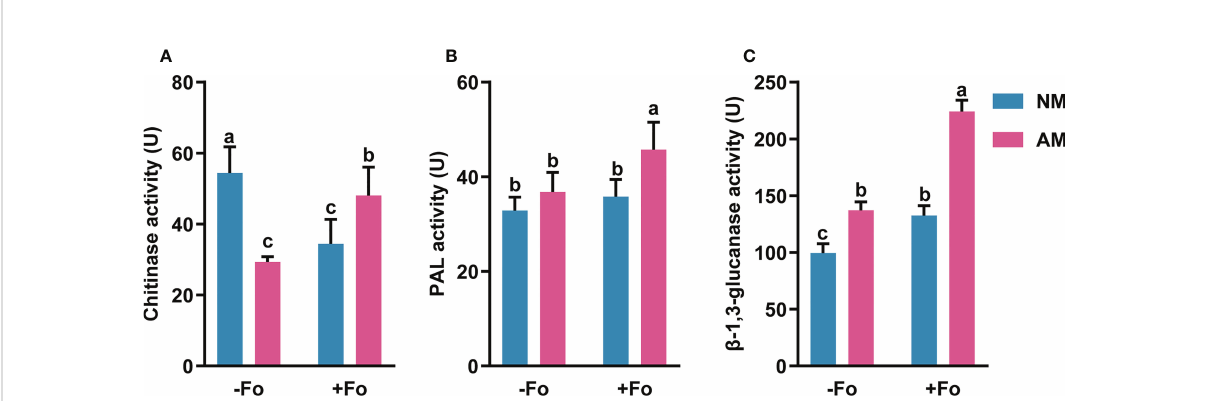
FIGURE 4 The activity of chitinase (A) , PAL (B) , and b -1,3-glucanase (C) in the roots of S. miltiorrhiza fi ve days after pathogen inoculation. Four treatments included: (1) NM-Fo: non-mycorrhizal S. miltiorrhiza inoculated with heat-killed pathogen inoculation; (2) NM+Fo: non-mycorrhizal S. miltiorrhiza inoculated with pathogen; (3) AM-Fo: mycorrhizal S. miltiorrhiza inoculated with heat-killed pathogen; (4) AM+Fo: mycorrhizal S. miltiorrhiza inoculated with pathogen. Values are means ± SD from four sets of independent experiments with 15 plants per treatment. Different lowercase letters indicate signi fi cant differences between different treatments according to two-way ANOVA followed by Tukey ’ s test for multiple comparisons ( P <